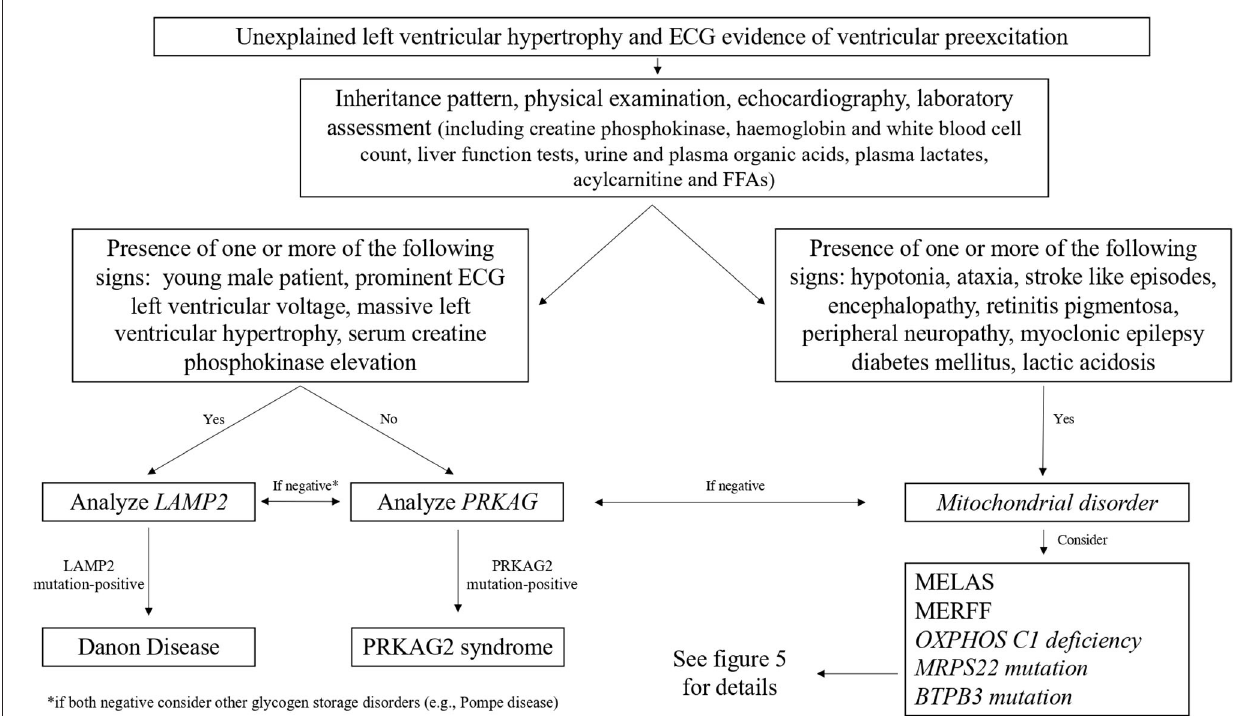
FIGURE 4 | Diagnostic flowchart in patients with unexplained left ventricular hypertrophy and electrocardiographic evidence of ventricular preexcitation. FFA, free fatty acids; MELAS, mitochondrial encephalomyopathy, lactic acidosis, stroke-like episodes; MERRF, myoclonic epilepsy with ragged red fibers.